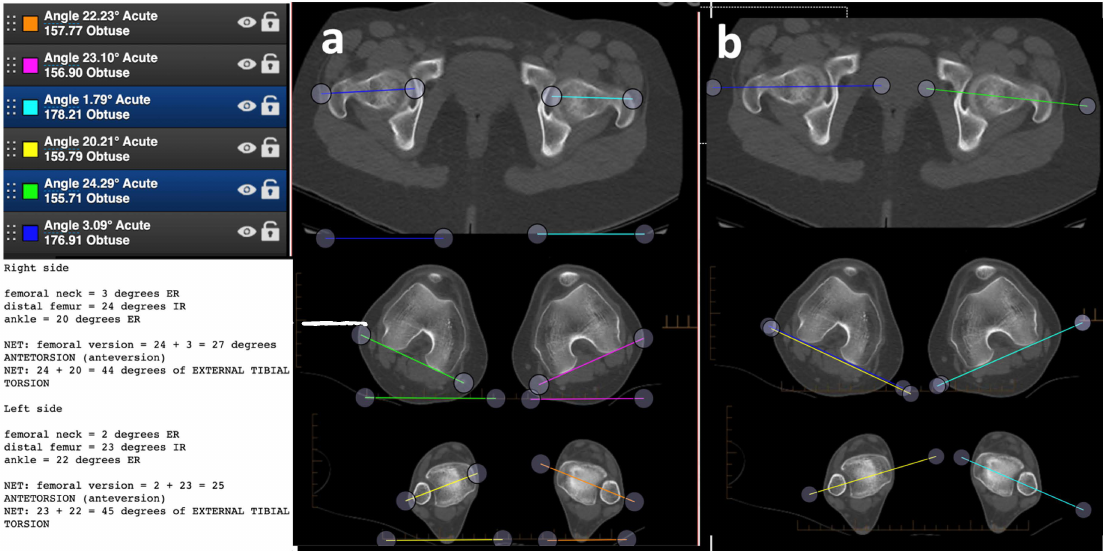
Figure 2. Examples of correctly measured angles on case 1. ( a ) Shows the angle lines drawn in the accepted example case. The top lines measure the femoral neck angle, the middle measures the posterior condylar angle, and the bottom measures the bimalleolar angle with respect to the horizontal; ( b ) this is an example of a variation in the measurement technique. Instead of comparing the angles to the horizontal, one can measure the femoral neck and bimalleolar angles with respect to the posterior condylar axis of the femur. This method eliminates addition and subtraction for femoral version and tibial torsion, but one must still determine if there is anteversion, retroversion, internal, or external tibial